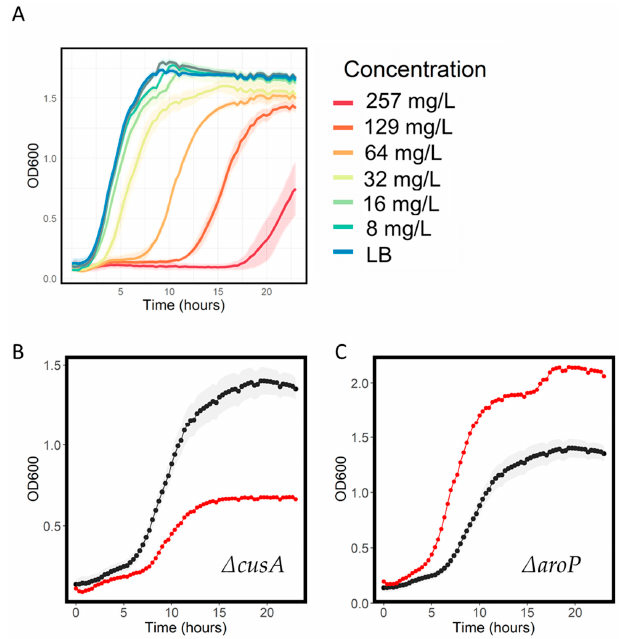
Figure 7. Growth features of paraquat. ( A ) Concentration inhibition data for growth of WT E. coli in the indicated concentration of paraquat. Shaded areas represent the standard deviation, n = 3. Growth curves for WT (black) and knockout strains (red) in 32 mg/L paraquat. ∆ cusB ( B ) and ∆ aroP ( C ) are shown. Table 4. Growth parameters for the 15 most sensitive and most resistant strains in paraquat. Nor- malized values represent the value in paraquat/value in LB for the given strain and values for the maximum OD, rate and area under the curve are shown. Normalized Normalized Max OD